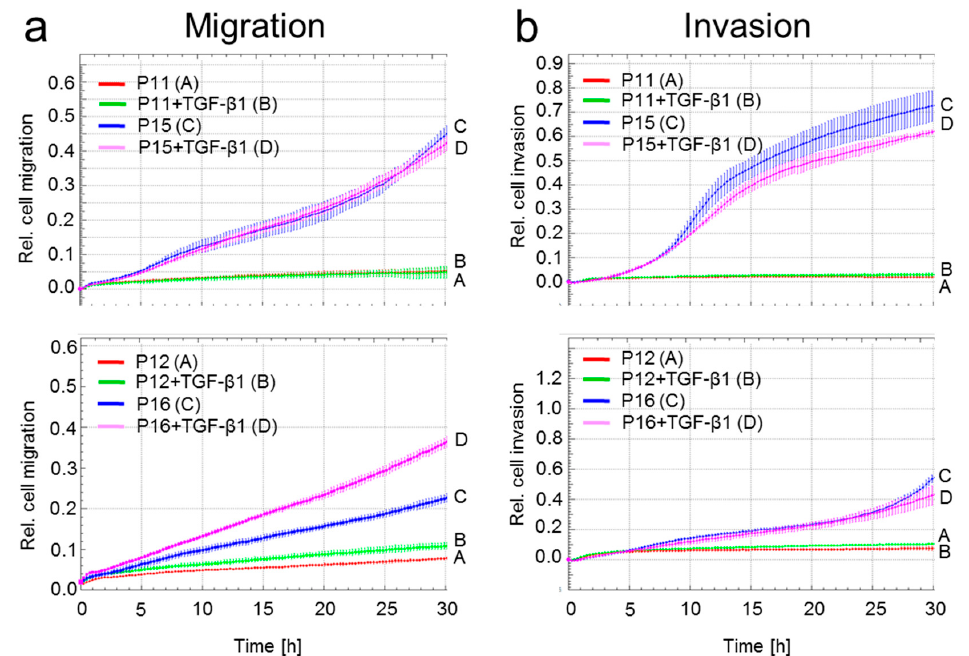
Figure 5. Effect of passage number on basal and TGF- β 1-mediated cell migration in HMEC. ( a ) P11 and P15 (upper graph) and P12 and P16 (lower graph) HMEC were subjected to migration assay in the presence or absence of rhTGF- β 1 (10 ng/mL). For P11 and P15 (upper graph) differences are significant between P11 HMEC (red curve, tracing A) and P15 HMEC (blue curve, tracing C) and between P11 HMEC + TGF- β 1 (tracing B) and P15 HMEC + TGF- β 1 (tracings C and D) at 10:00 and all later time points. For P12 and P16 (lower graph) differences are significant between P12 HMEC (red curve, tracing A) and P16 HMEC (blue curve, tracing C) and between P12 HMEC + TGF- β 1 (green curve, tracing B) and P16 HMEC + TGF- β 1 (magenta curve, tracing D) at 8:00 and all later time points; ( b ) P11 and P15 (upper graph) and P12 and P16 (lower graph) HMEC were subjected to invasion assay with matrigel as barrier in the presence or absence of rhTGF- β 1 (10 ng/mL). For P11 and P15 (upper graph) differences are significant between P11 HMEC (red curve, tracing A) and P15 HMEC (blue curve, tracing C) and between P11 HMEC + TGF- β 1 (green curve, tracing B) and P15 HMEC + TGF- β 1 (magenta curve, tracing D) at 8:00 and all later time points. For P12 and P16 (lower graph) differences are significant between P12 HMEC (red curve, tracing A) and P16 HMEC (blue curve, tracing C) and between P12 HMEC + TGF- β 1 (green curve, tracing B) and P16 HMEC + TGF- β 1 (magenta curve, tracing D) at 20:00 and all later time points.